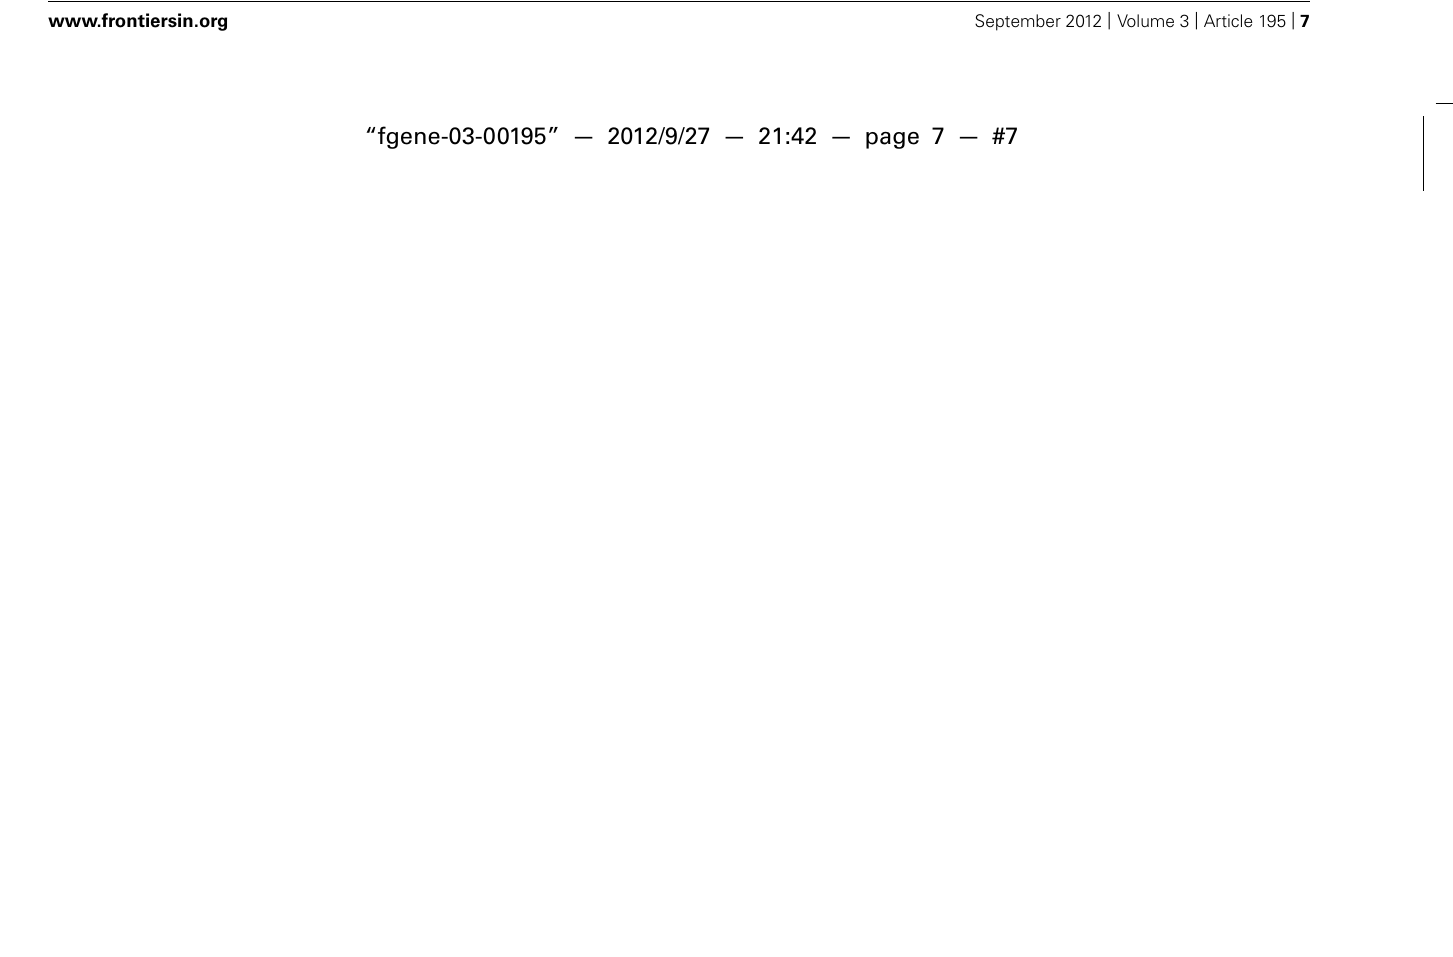
FIGURE 2 | Model depicting how sequence variation in distal regulatory elements might influence phenotypes or disease states. A phenotype associated SNP rsXXXXX is located in an enhancer for gene X.TheT allele of rsXXXXX binds a transcription factor (the gray pentagon) with high affinity which allows for chromatin loop formation and proper activation of gene X resulting in normal development (left, green arrows).The C allele of rsXXXXX binds the transcription factor with a reduced affinity (light gray pentagon with